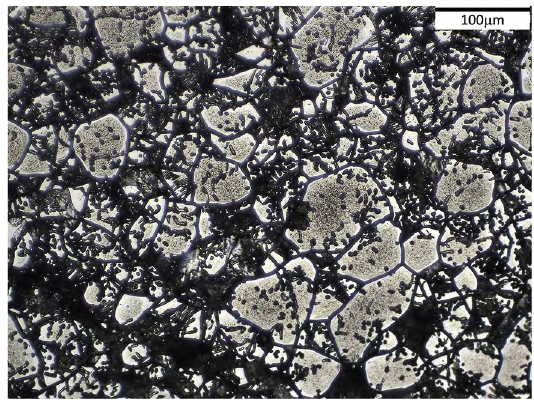
Figure 11. Micrographs of D2 condition revealing the chromium nitride presence. Electrolytic etching with oxalic acid. OM-200x.